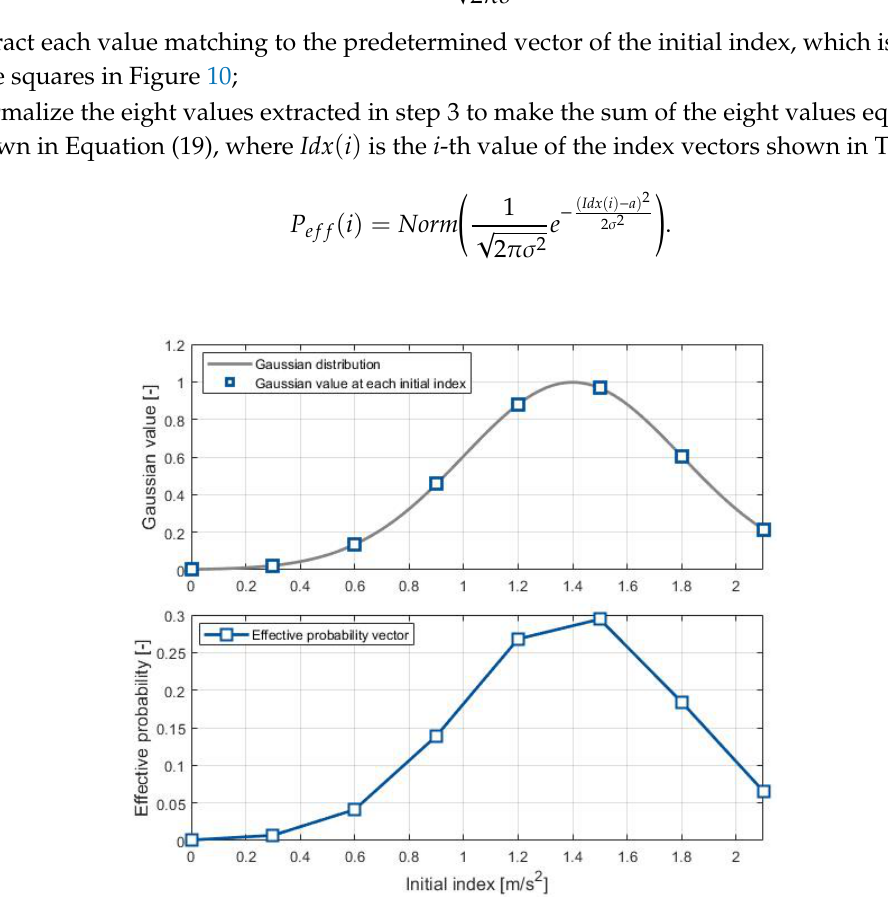
Figure 9. Learning vector of initial jerk. Table 4. Example of learning vector for initial jerk.